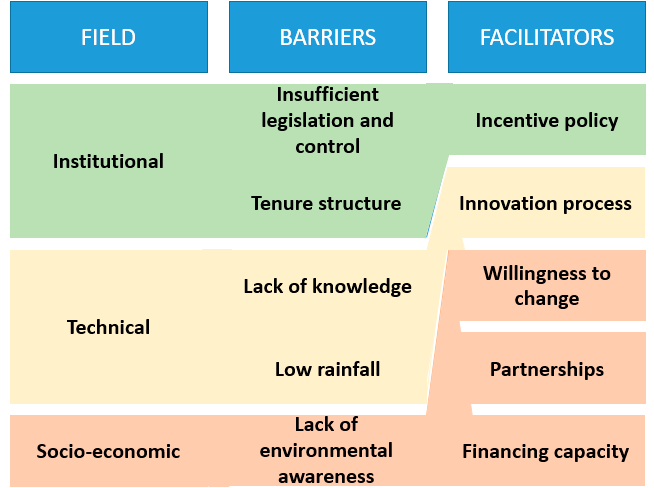
Figure 2. Main barriers and facilitators for the adoption of sustainable practices.